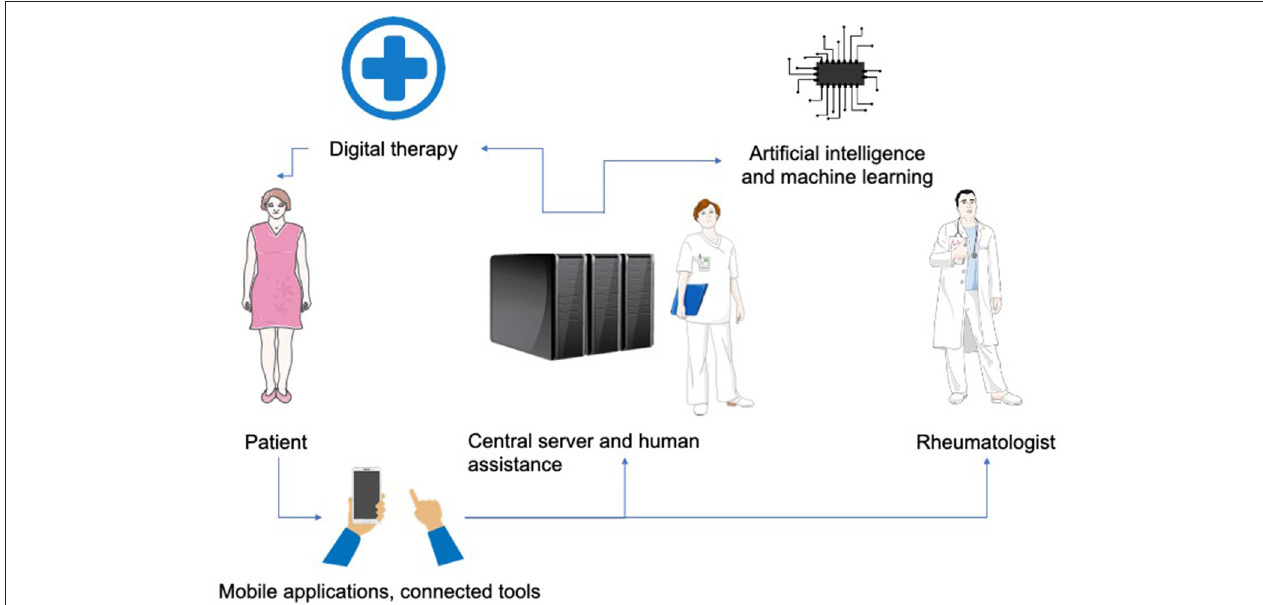
FIGURE 2 | A general overview of telemedicine technologies integrated into medical practice in rheumatology. Patients upload data about their health status via mobile applications and online tools. This feedback is integrated into a central server and transmitted to the rheumatologist and other participants in the telemedicine system. Data analysis supported by human assistance and artificial intelligence assists rheumatologist in their medical practice (diagnosis, prognosis, therapy, follow-up) and provides patients with active assistance in the treatment and management of their pathology.